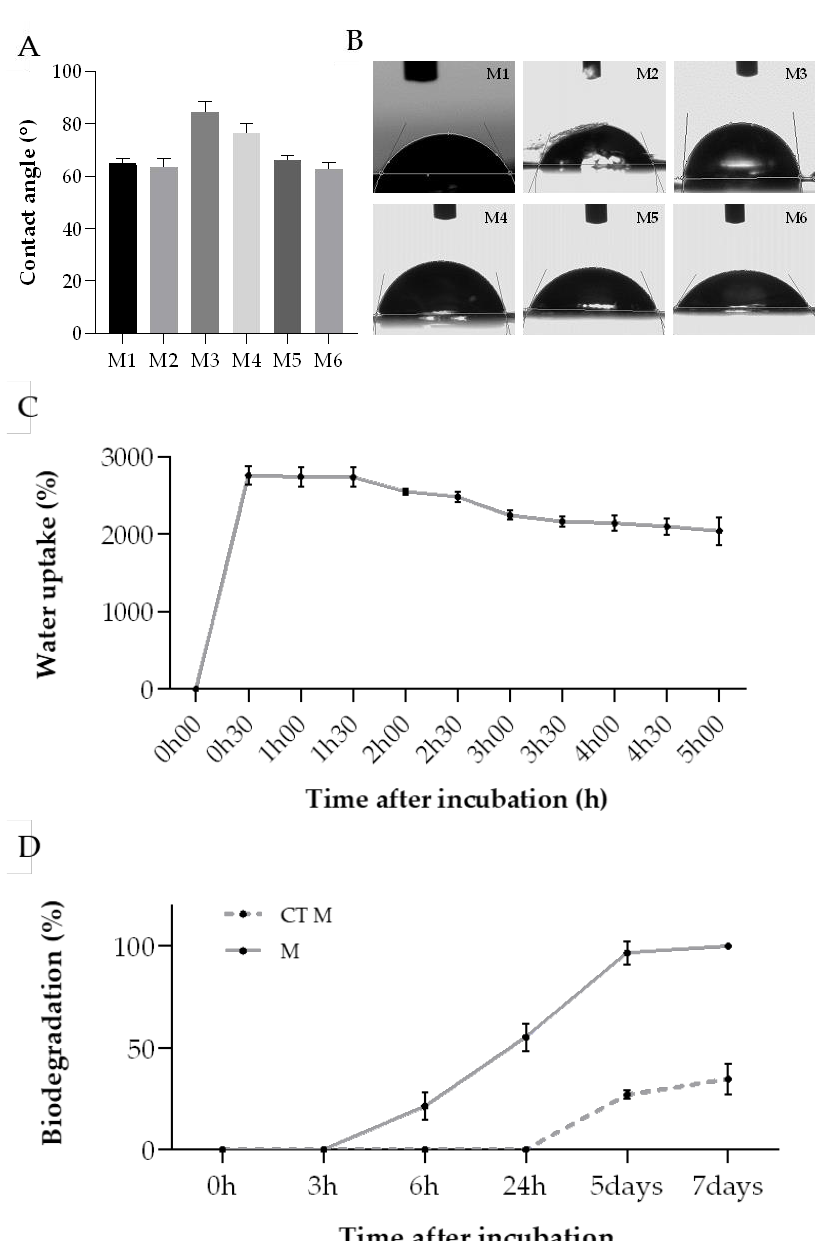
Figure 7. ASColl membranes physic-chemical properties analysis. ( A )—WCA value for each membrane. ( B )—Images of water drops on the collagen membranes. MX-membrane produced with collagen from the extraction X. ( C )—Water uptake rate of the ASColl membranes. ( D )—In vitro biodegradation ratio of the collagen membranes. M-membranes incubated in PBS with collagenase; CT M-membranes incubated in PBS only. The presented values are mean ± SD of three independent